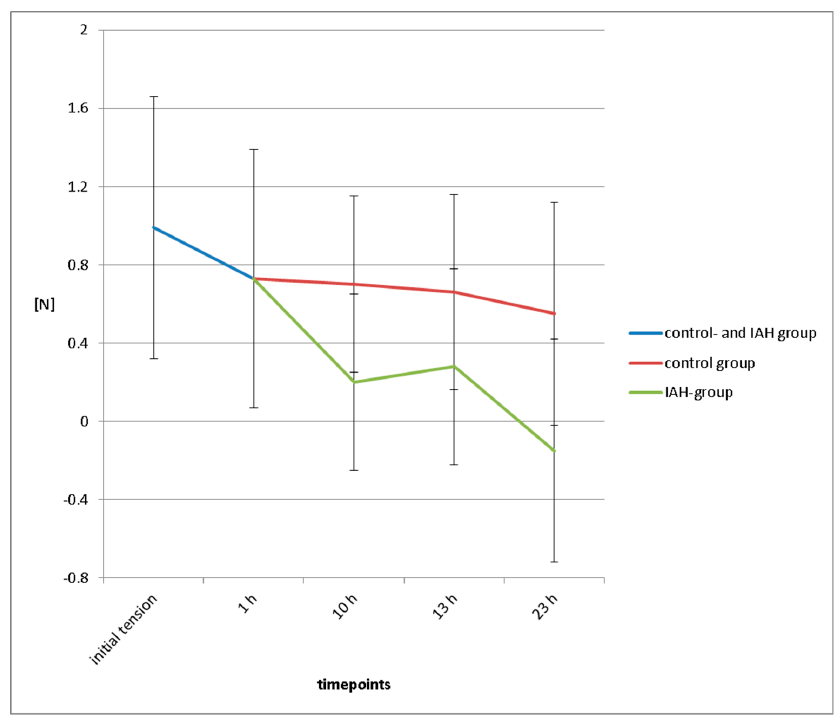
Figure 6. Mean suture tension levels immediately after completion of the suture and after 1, 10, 13, and 23 h in the control and intervention groups, depicted together with standard deviations.